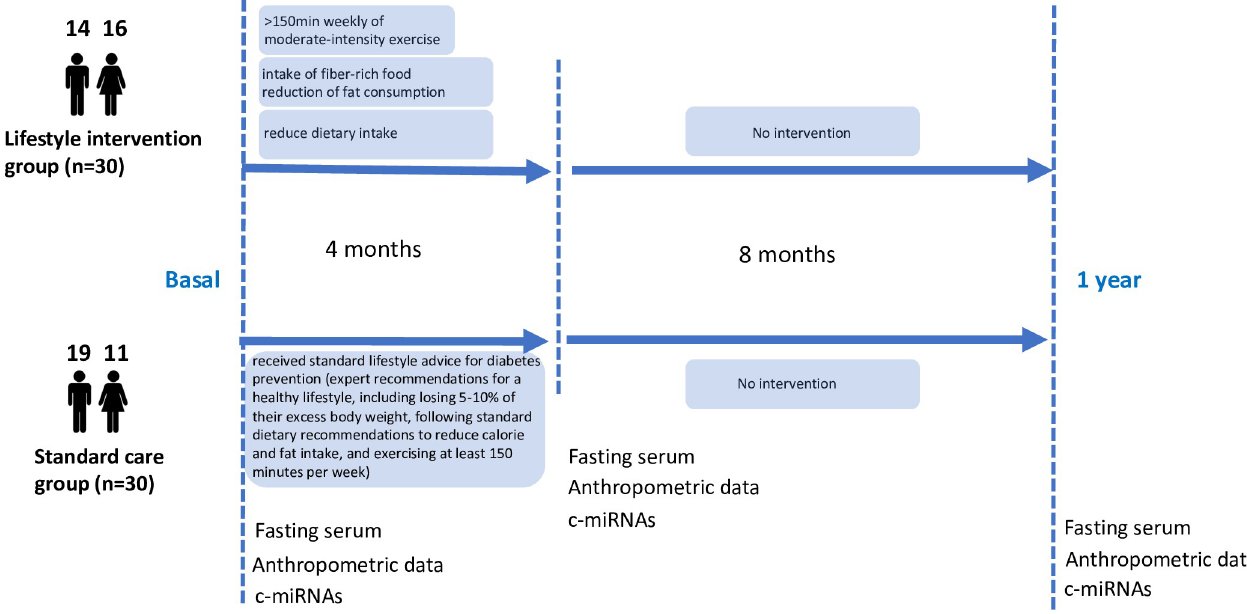
Fig 1. Summary of the protocol showing when metabolic/anthropometric data and c-miRNA/cytokines levels were quantified in serum from obese pre- diabetic Indian patients. All the patients belong to the cohort D-CLIP [16].